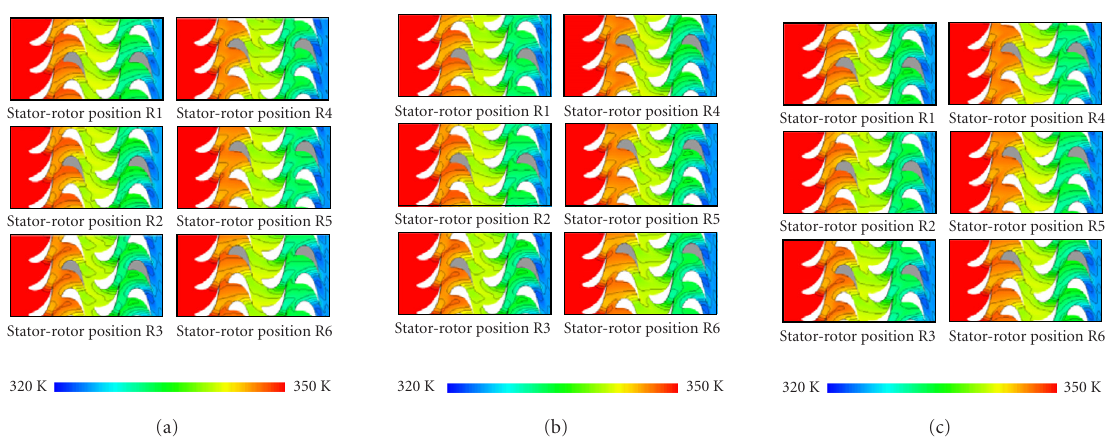
Figure 5: Absolute temperature distributions in the steady calculations (frozen rotor approach): (a) clocking position s1, (b) clocking position s2, and (c) clocking position S3.